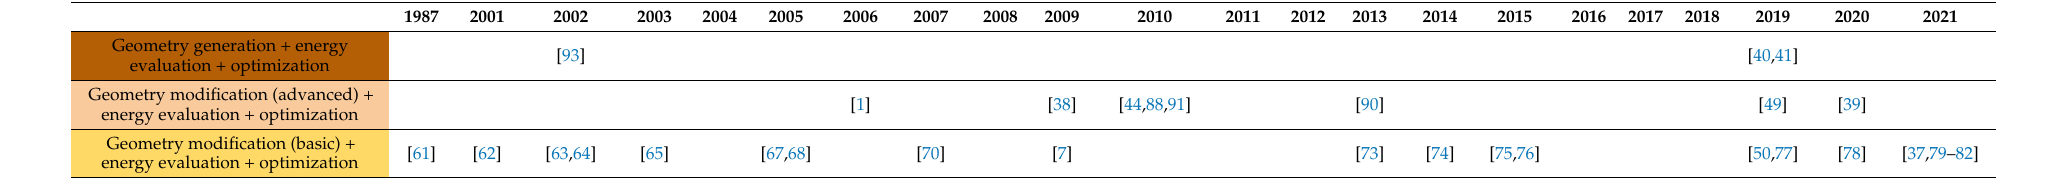
Table 4. Research focusing on studies with geometry modification and geometry generation with and without energy evaluation and optimization in chronological